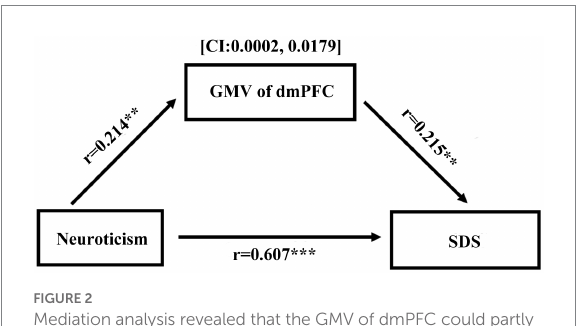
FIGURE 2 Mediation analysis revealed that the GMV of dmPFC could partly